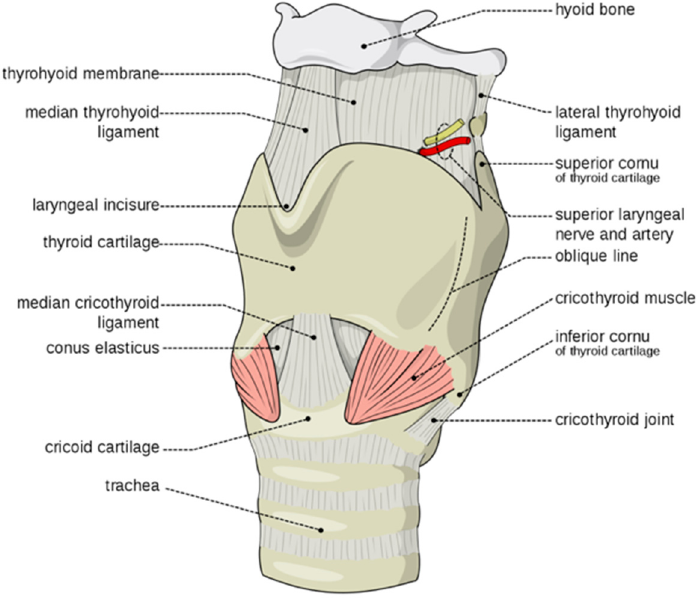
Figure 1. Laryngeal Development. Postnatal descent of the human larynx. Human larynx after its postnatal descent separating the thyroid cartilage from the hyoid by Olek Remesz based on: Gray951.png, CC BY-SA 2.5, https://commons.wikimedia.org/w/index.php?curid=3492701 (accessed on 10 June 2022).